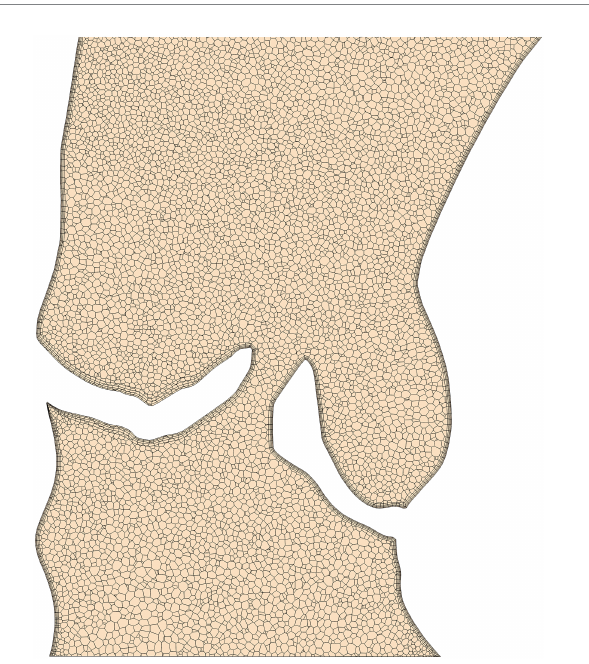
FIGURE 2 An example of the computational mesh structure in the aortic valve and ascending aorta used for the computational fluid dynamics simulations. The boundary layer structure used to resolve near wall flow can be seen around the valve and vessel